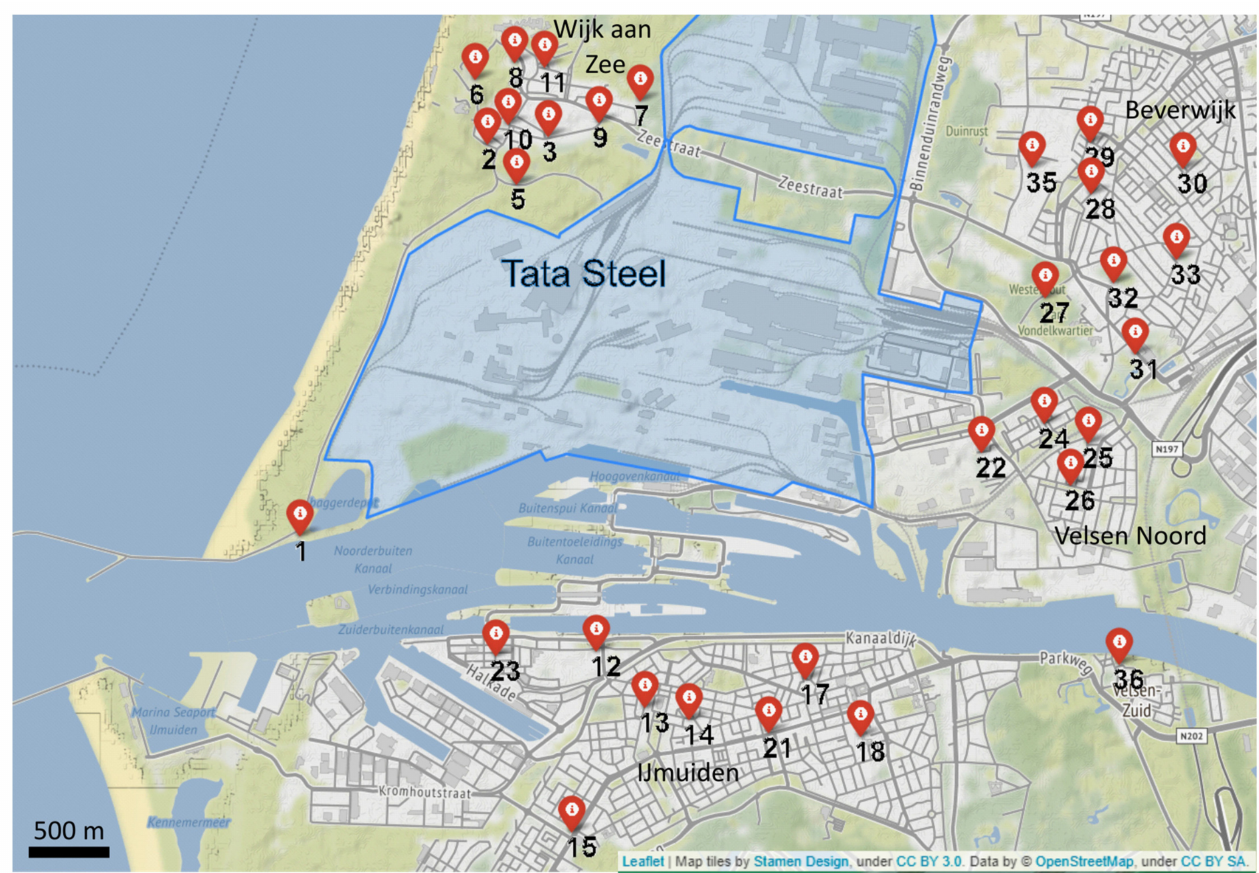
Figure 1. Map showing sampling locations in the IJmond Region of dust deposit samples